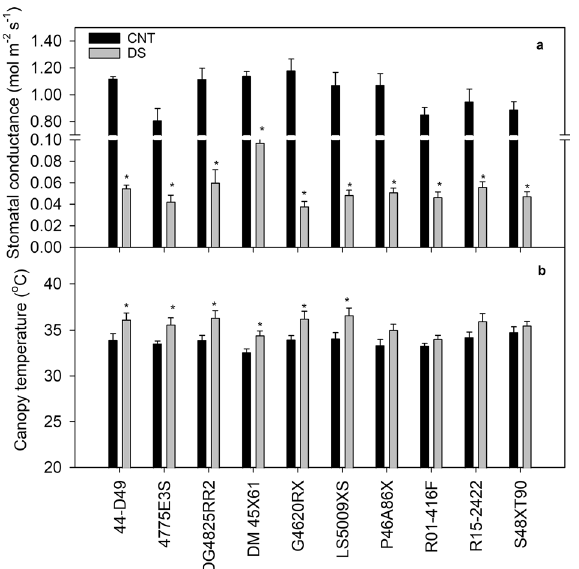
Figure 2. Stomatal conductance ( a ) and canopy temperature ( b ) responses of ten soybean cultivars under control (CNT) and drought stress (DS). The vertical bars represent mean of ten replicates ± SE. *indicates a significant difference between the CNT and DS for the given cultivar at p <